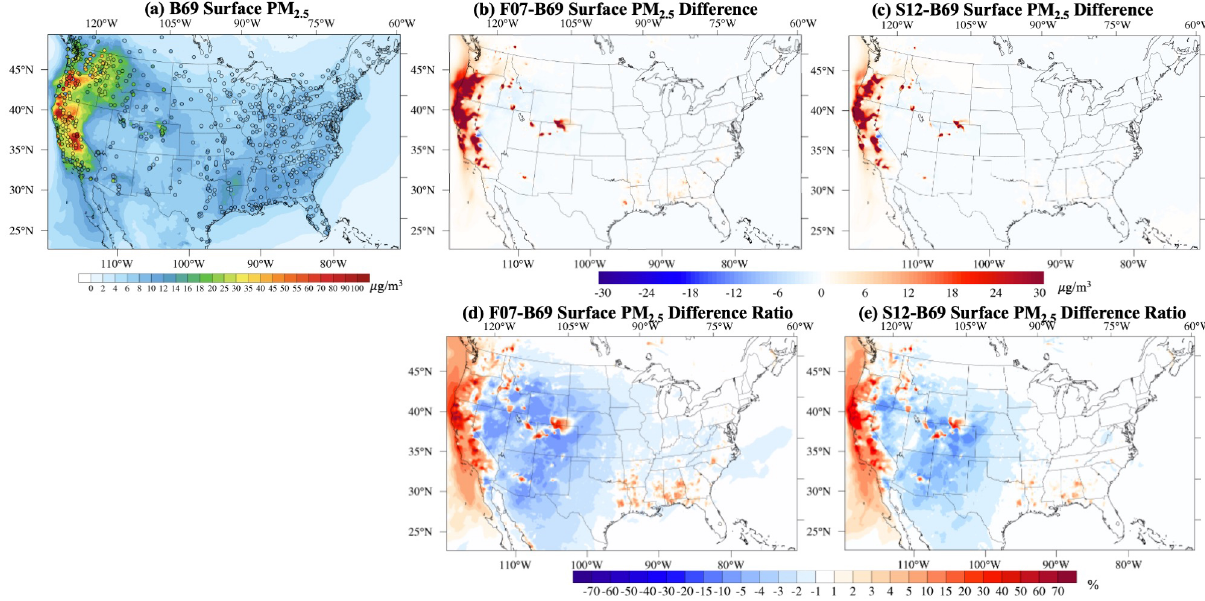
Figure 10. Simulated and observed surface PM 2 . 5 from 1 August to 30 September 2020. (a) Average surface PM 2 . 5 simulated with B69 overlaid by AirNow observations. (b) Difference in averaged surface PM 2 . 5 between F07 and B69. (c) Difference between S12 and B69. Panels (d) and (e) are the same as panels (b) and (c) but for the differences in percentage (%) between F07 and B69 and between S12 and B69,